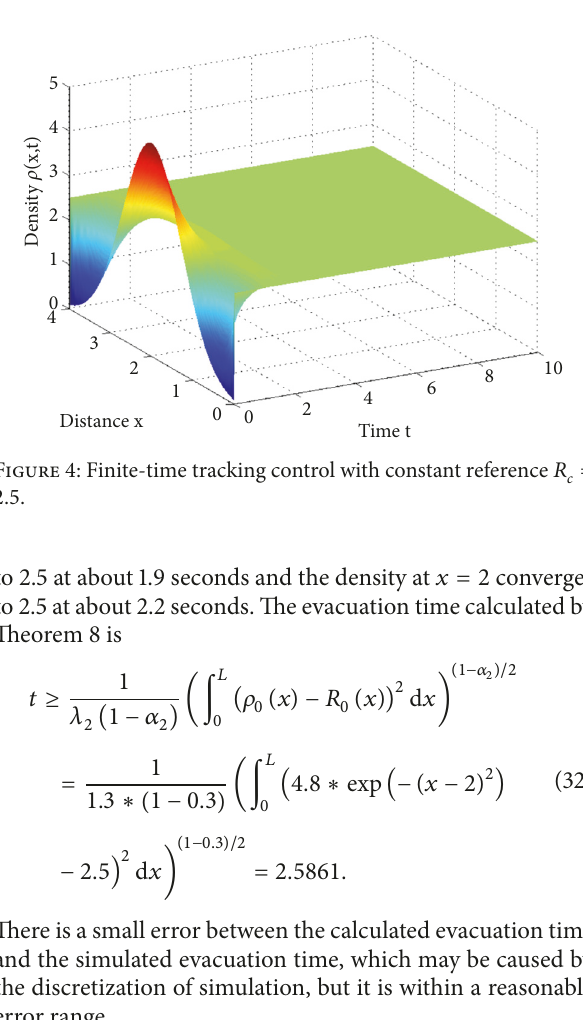
Figure 1: Density response of the uncontrolled crowd evacuation system.